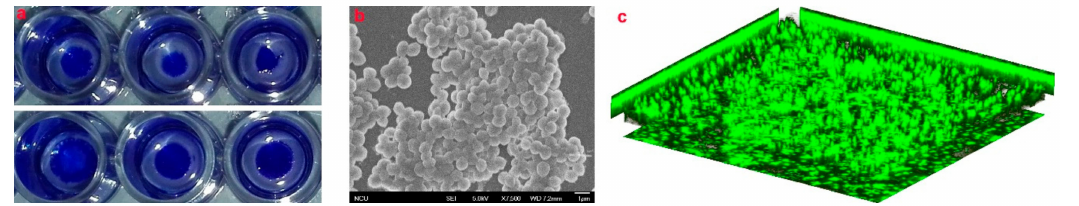
Figure 2. Biofilms of Staphylococcus aureus . ( a ) Biofilms, in the wells of two 96-well plates, stained blue with crystal violet; ( b ) biofilms on a plastic disk were presented under scanning electron microscopy (7500 × ); ( c ) biofilm (634.7 × 634.7 × 54.0 µ m 3 , length × width × height) on a silica disk were observed using confocal laser scanning microscopy.